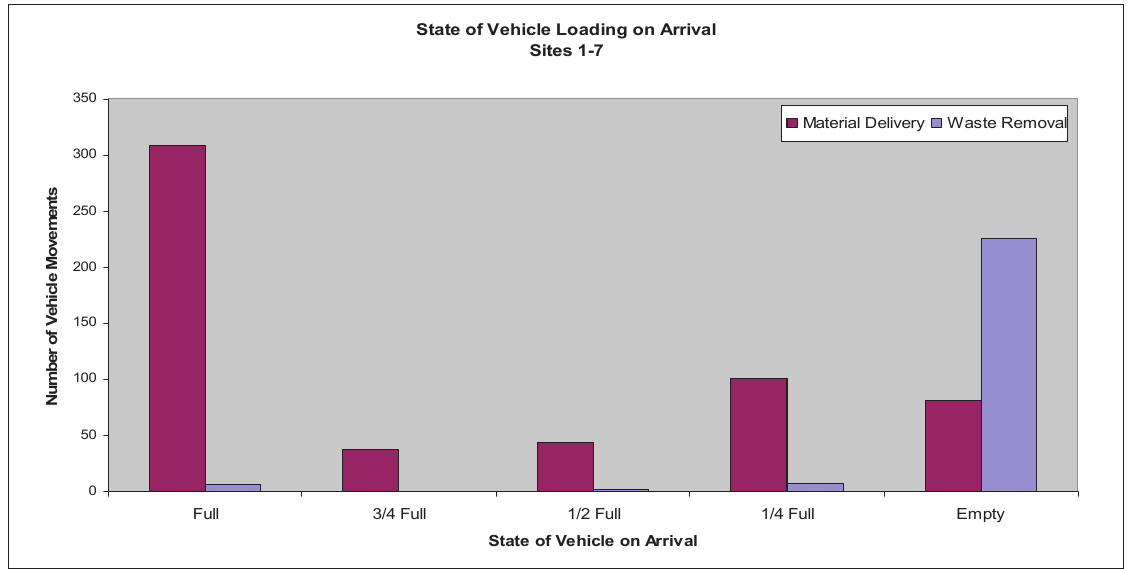
Figure demonstrates graphically